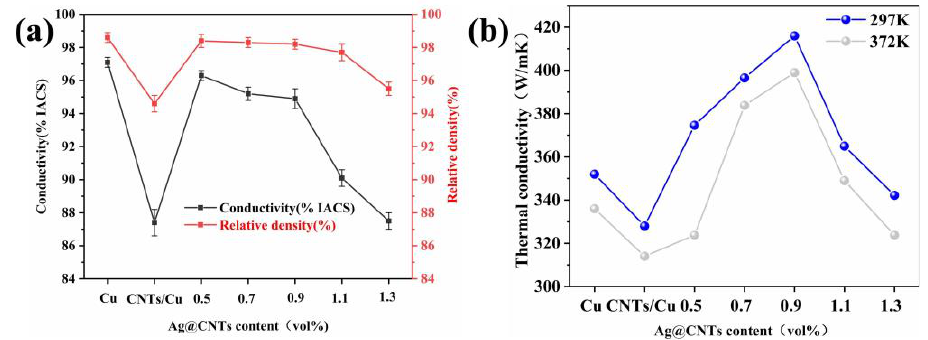
Figure 9. ( a ) Electrical conductivity/density; ( b ) thermal conductivity.